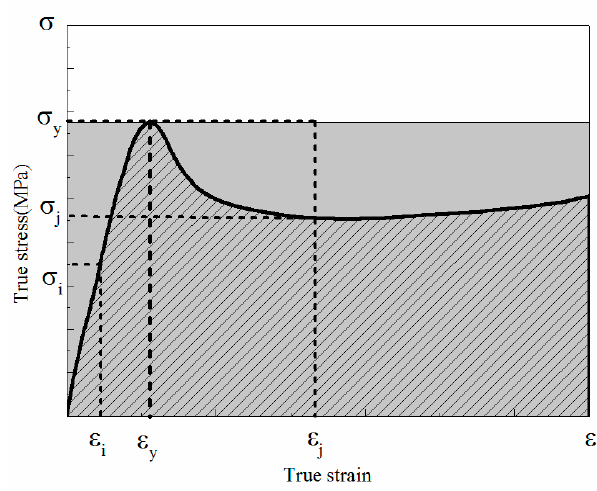
Figure 4. Energy absorption calculating process.